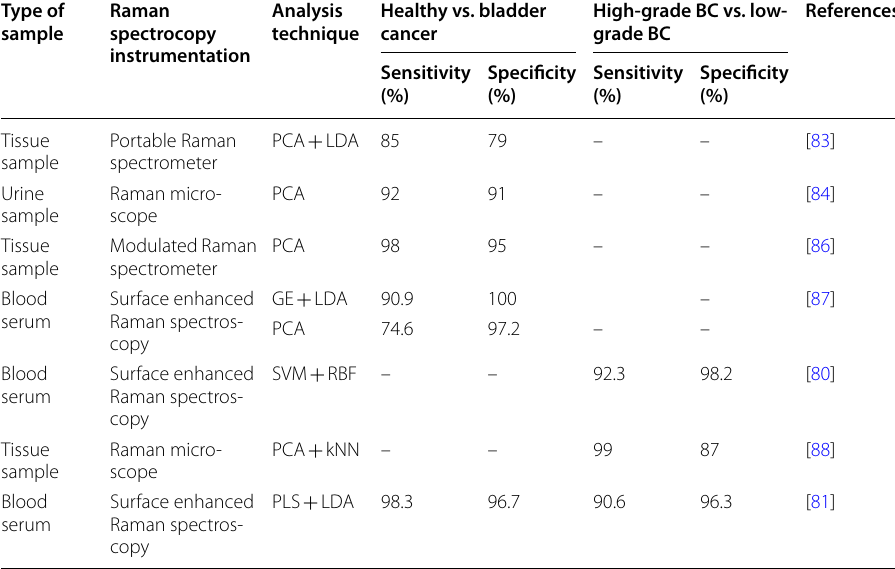
Table 2 Assessment of recent studies in the diagnosis bladder cancer (BC) in terms of the sensitivity and specificity provided by Raman